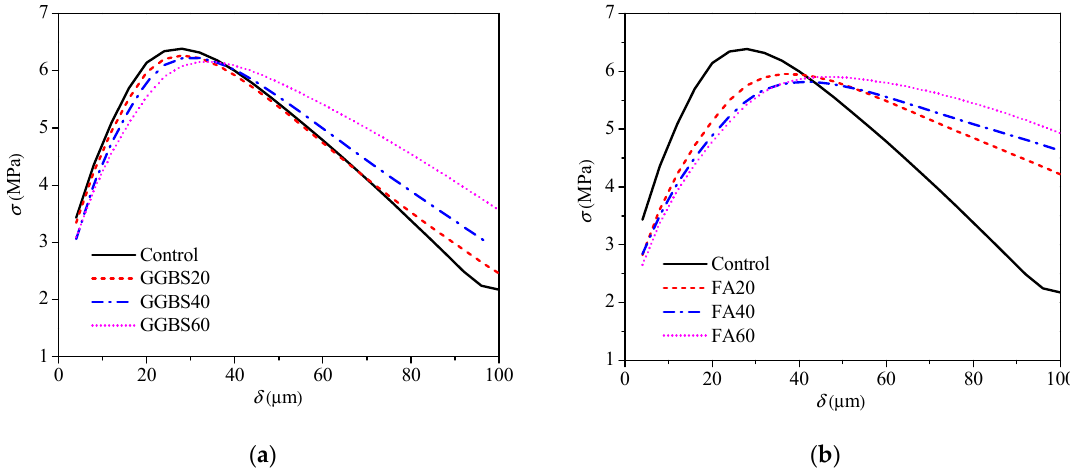
Figure 16. Predicted fiber-bridging stress versus crack opening curve of ULHS-ECCs: ( a ) GGBS; ( b ) FA.